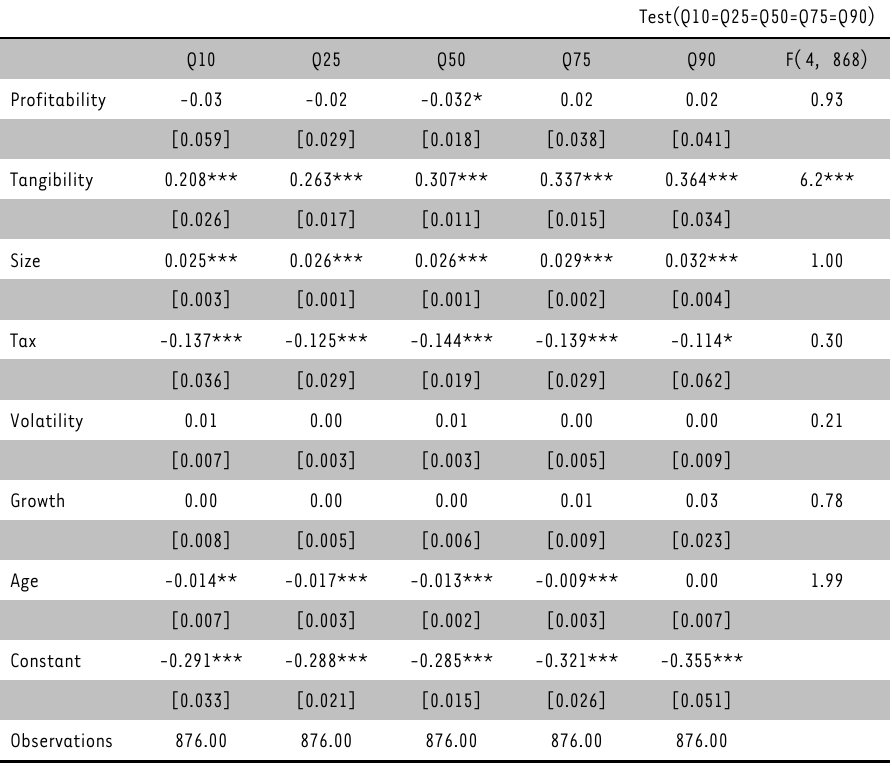
TABLE 3: Results when using Long Term Debt Ratio (LTR) as the Dependent